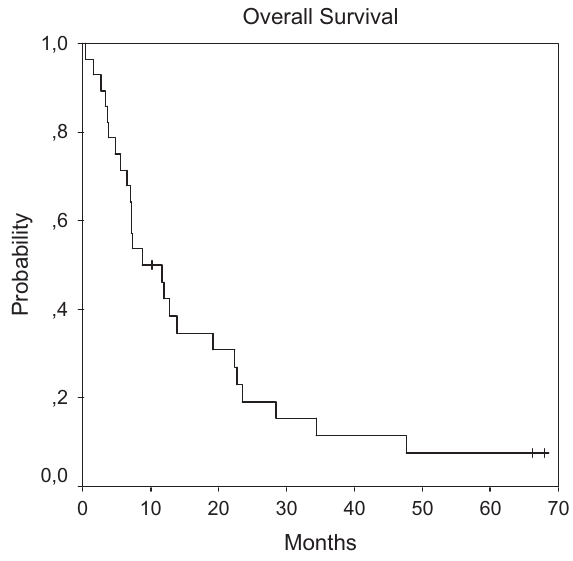
Figure 2. Overall